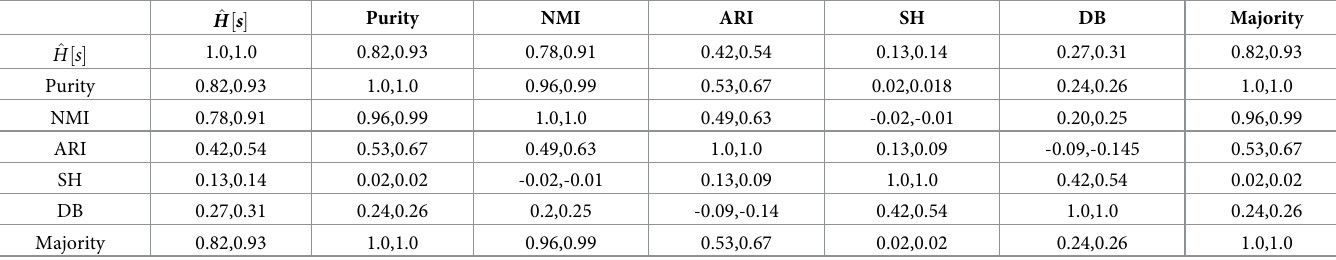
Table 16. Kendall’s τ and Spearman’s correlation result for